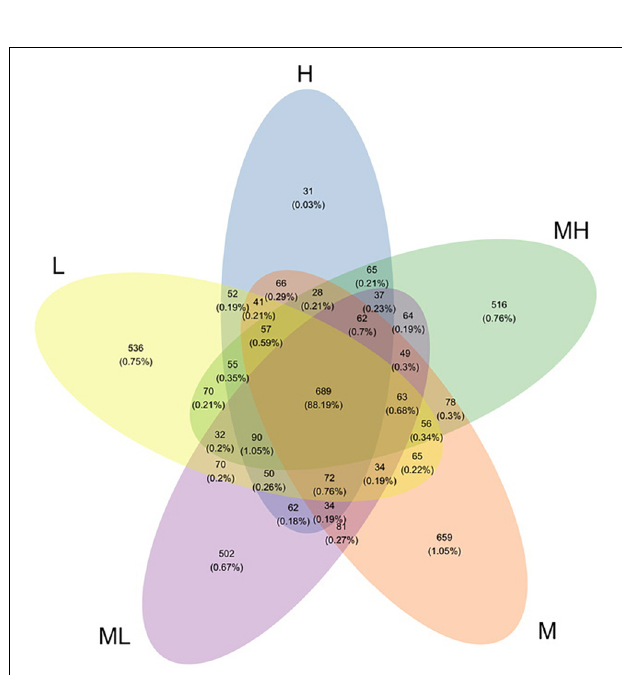
FIGURE 2 | Venn diagram at the 97% similarity level. H group: 33.0% peNDF 1 . 18 treatment. MH group: 29.9% peNDF 1 . 18 treatment. M group: 28.1% peNDF 1 . 18 treatment. ML group: 26.5% peNDF 1 . 18 treatment. L group: 24.8% peNDF 1 . 18